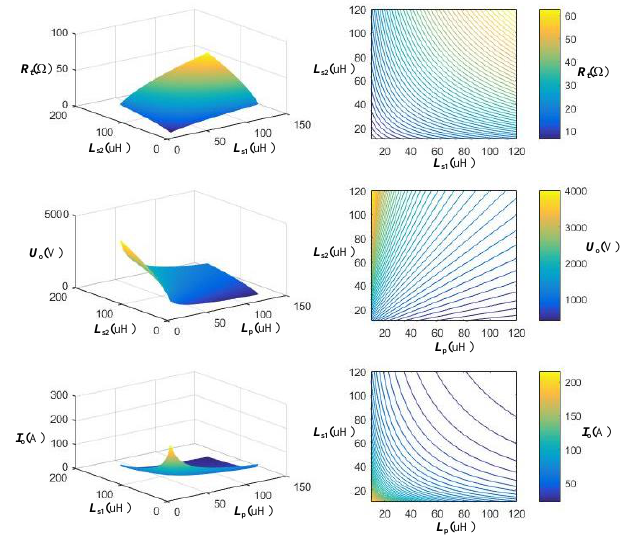
Figure 18. Contour map of system parameters ( U O , I O , R t and L p , L s1 , L s2 ).